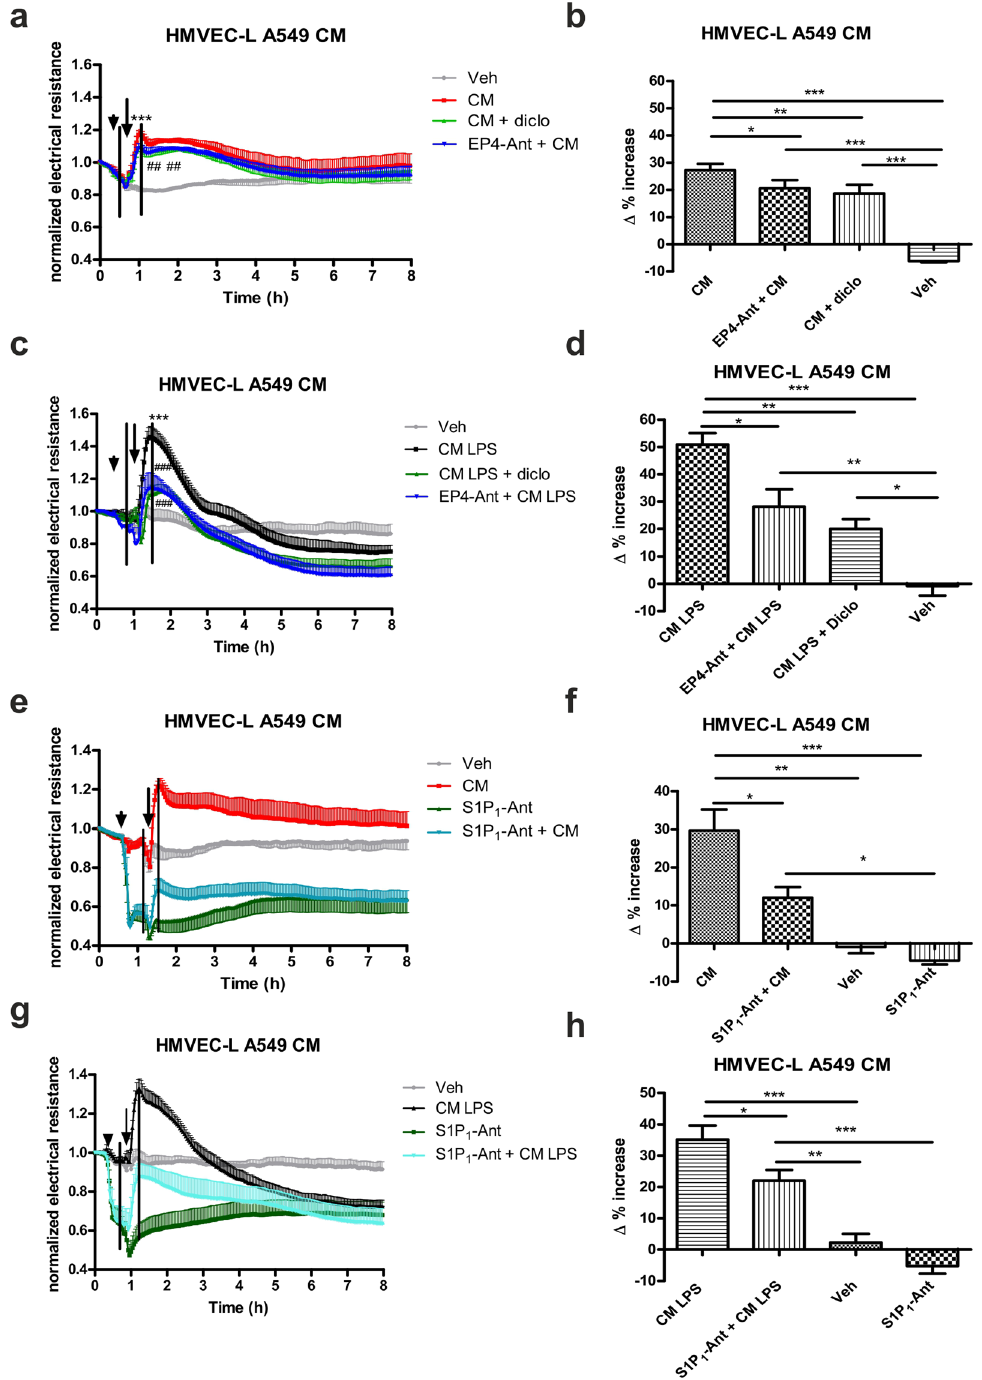
Figure 5. Conditioned medium (CM) from A549 cells increases endothelial barrier function via PGE 2 and S1P 1 receptor activation. HMVEC-L were grown on gold microelectrodes and were pretreated (arrowhead) with vehicle (Veh), the ( a,c ) EP4 antagonist ONO AE3-208 (EP4 Ant; 300 nM) or the ( e,g ) S1P 1 antagonist W146 (S1P 1 -Ant; 10 µ M). CM from ( a,e ) vehicle, ( c,g ) LPS treated (10 µ g/ml) and/or diclofenac-pretreated (diclo 10 µ M) A549 cells or corresponding medium (Veh) was added (indicated by arrow). To detect differences in barrier function (measured as change in resistance), Δ % values were calculated. The black lines mark the time points which were used to calculate Δ % increase shown in ( b,d,f,h ). ( a,c,e,g) Data show mean normalized resistance + SEMs; ( b,d,f,h ) Δ % increase was calculated by subtracting normalized resistance of the first time point marked in ( a,c,e ) or ( g ) from the second time point, and multiplying the value with 100. Statistical analysis was performed using two-way ANOVA and Tukey’s multiple comparison test for ( a,c,e ) and ( g ) and one-way ANOVA followed by Bonferroni’s post hoc test for ( b,d,f) and ( h ); n = 5–6, * p < 0.05; ** p < 0.01; *** p < 0.001; * vs vehicle; # vs CM